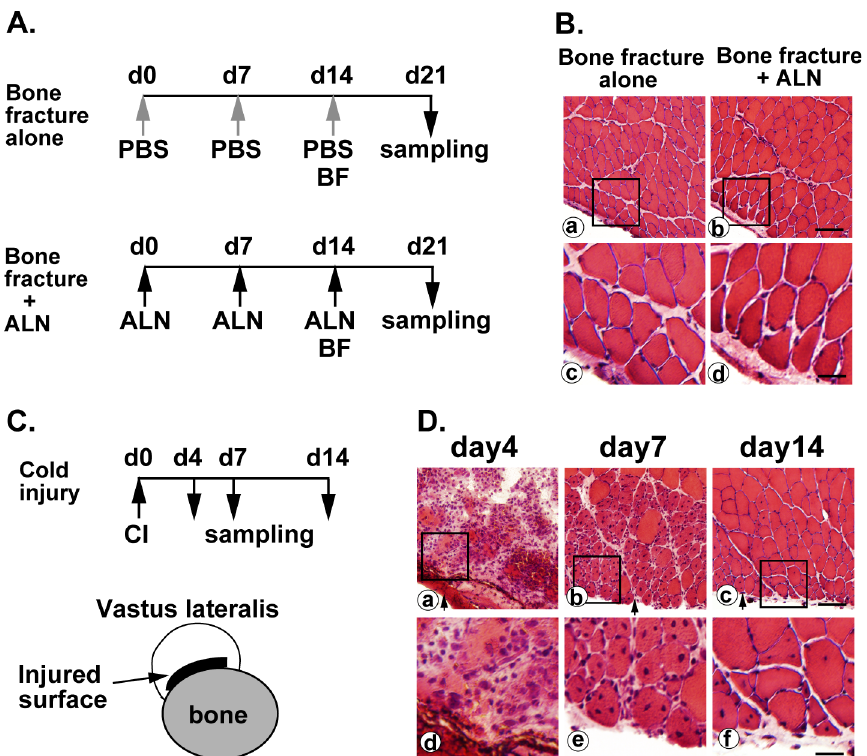
Fig 1. Effects of alendronate, bone fracture, and cold injury on muscle regeneration. (A) Experimental schedules.PBS (gray arrows) or alendronate(black arrows) was subcutaneously injected at seven-day intervals. The femur was broken on day 14 and removedon day 21. In the cold injury experiment, the vastus lateralis muscle was removed on day 4, 7, or 14 after a singlecold injury. ALN, alendronate; BF, bone fracture. (B) Vastus lateralis muscles were sectionedand stainedwith hematoxylin and eosin. Squaresin the top panels(a and b) indicatethe areas magnifiedin the bottom panels(c and d). Scale bars, 60 μ m in (a and b), 20 μ m in (c and d). (C) Experimental scheduleand schematic view of injuredarea of vastus lateralis. CI, cold injury. (D) Histopathology of muscle regeneration of vastus lateralisafter cold injury. Arrows in (a-c) represent the surface injuredby cold shock. Squares in the top panels (a-c) indicate the areas magnifiedin the bottom panels(d-f). Scale bars, 60 μ m in (a-c), 20 μ min (d-f).